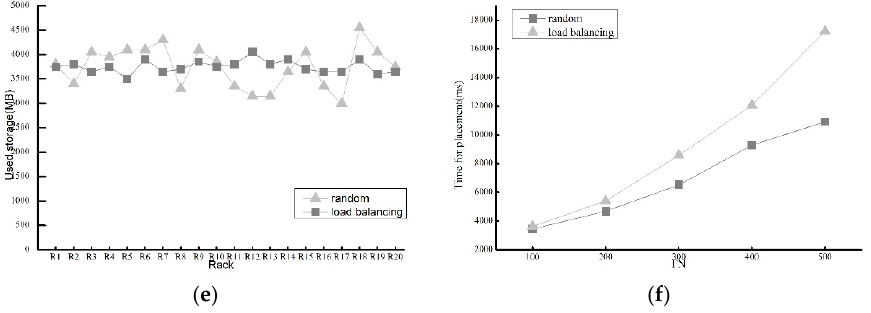
Figure 7. Storage load of two kinds of load balancing methods. ( a ) Storage usage when FN = 100; ( b ) Storage usage when FN = 200; ( c ) Storage usage when FN = 300; ( d ) Storage usage when FN = 400; ( e ) Storage usage when FN = 500; ( f ) Average deploying time with variable FN.